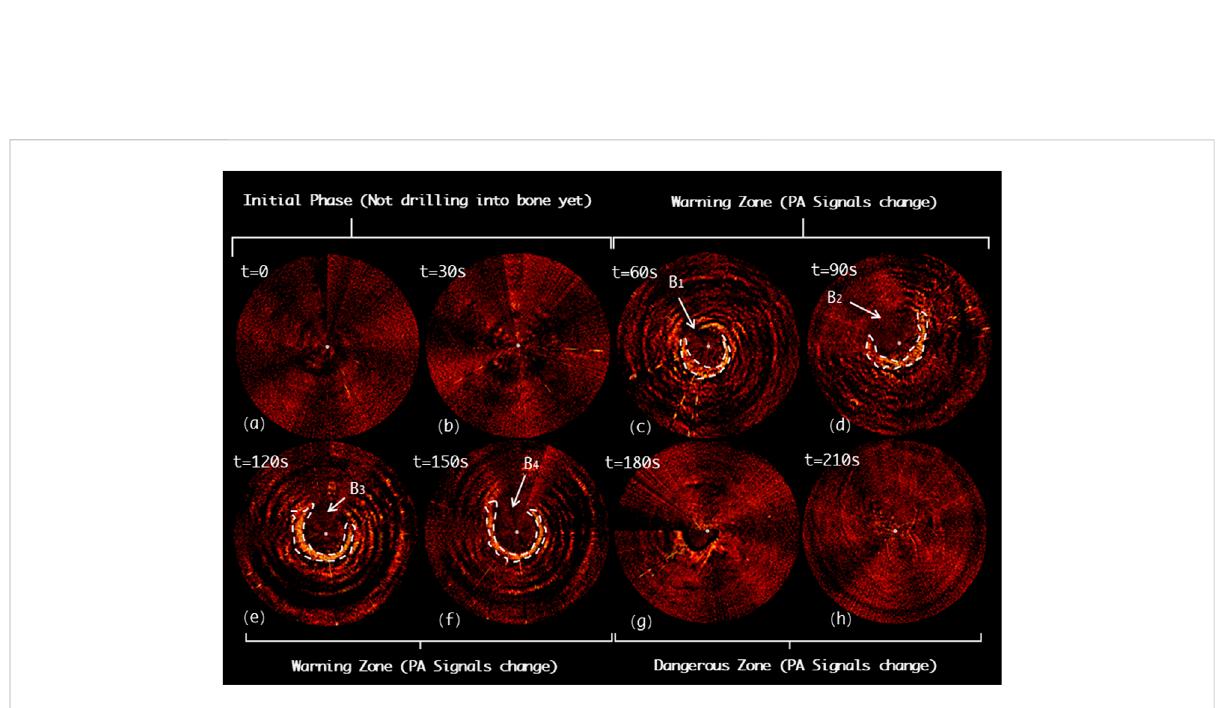
FIGURE 13 Acquired PAE images along the medial misplacement path (MMP) for in situ bone tissue sensing. (A-B) Initial phase; (C-F) Warning zone; (G-H) Dangerous